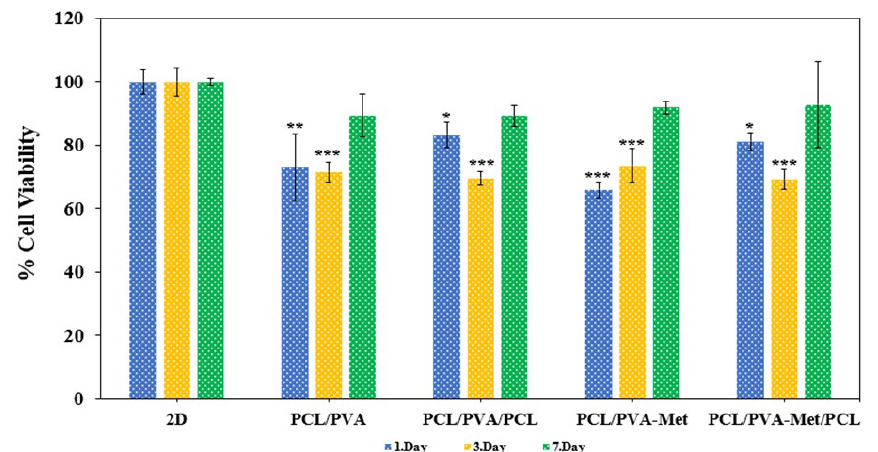
Figure 7. In vitro cell viability analysis using MTT assay of the fabricated scaffolds (* p < 0.05, ** p < 0.01, *** p < 0.001).